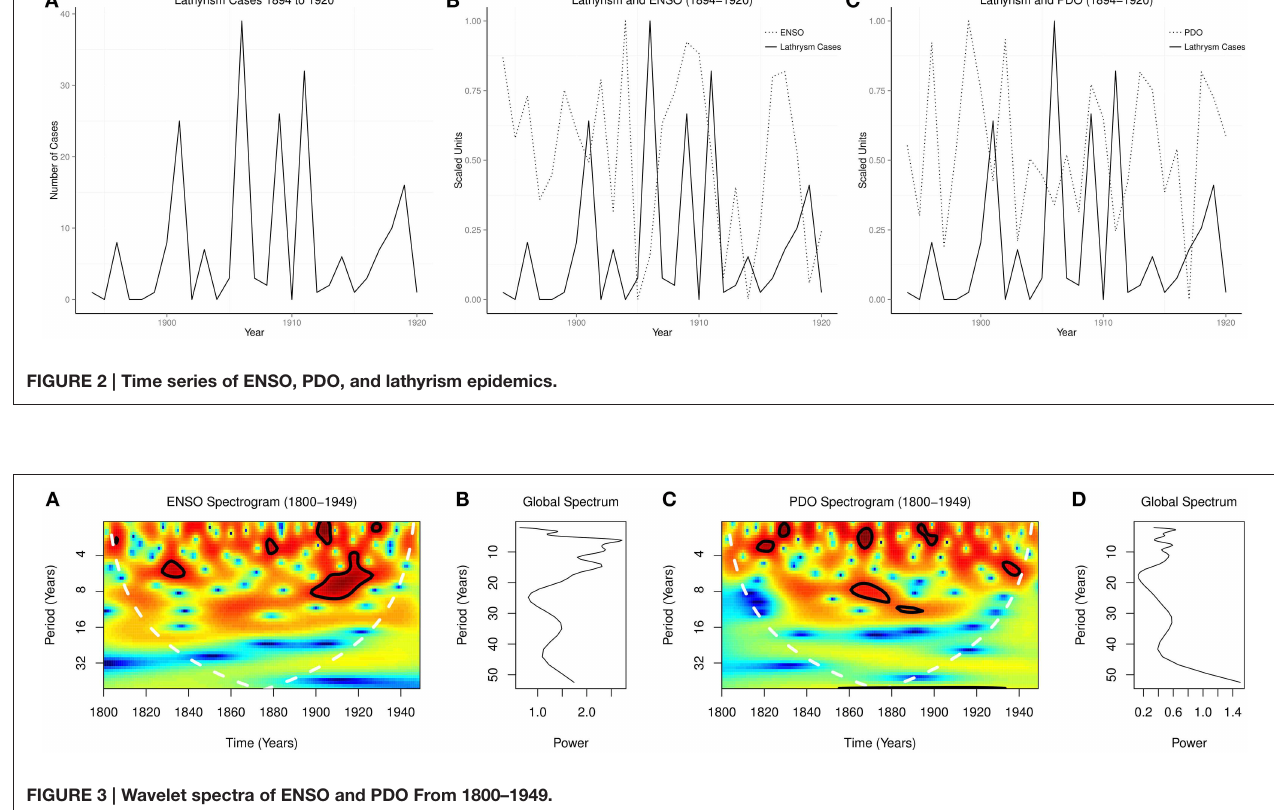
FIGURE 3 | Wavelet spectra of ENSO and PDO From 1800–1949.